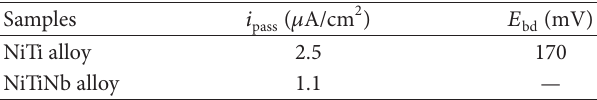
T 1: e mean values of corrosion parameters measured for both samples in physiological 0.9 wt